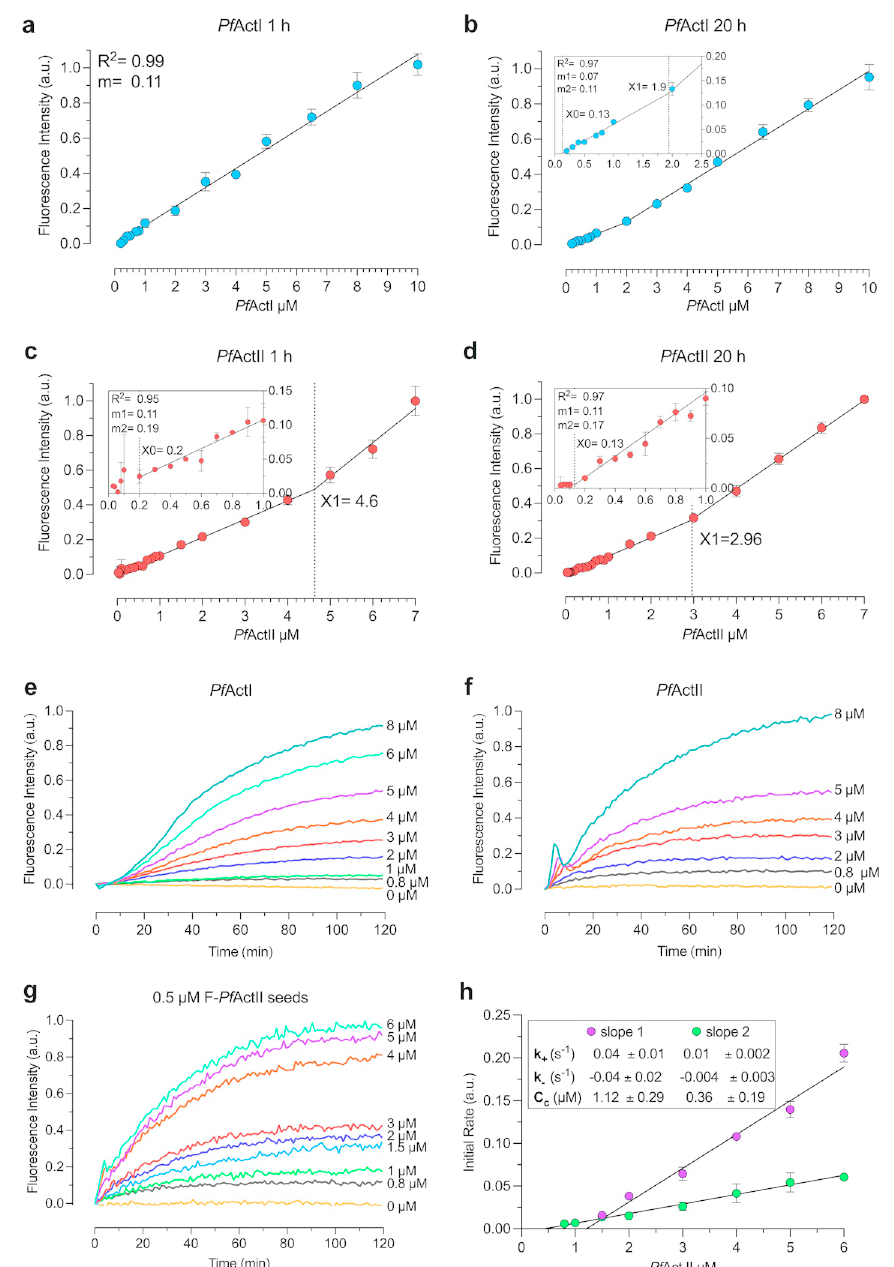
Fig 8. Polymerization kinetics of Plasmodium actins. a-d. C c plots of Plasmodium actins in F-buffer. C c plot of actin I after 1 h (n b = 2) (a) and 20 h (n b = 2) (b) of incubation at 4˚C, using 0.002 to 10 μ M actin. The data fit a single regression line in (a) and a segmented equation in (b) . X0 agrees with the C c previously reported (0.13 μ M), and X1 was 1.9 μ M. C c plot of actin II after 1 h (n b = 5) (c) and 20 h (n b = 3) (d) of incubation, using 0.002 to 7 μ M actin. Actin II exhibited a critical concentration of 0.2 μ M (indicated as X0). The C c decreased to 0.13 μ M after 20 h, as seen in (d). X1 indicates the crossing point value between the two slopes. The lower concentration points are zoomed on the left. Actin II polymerization (e-h) . Spontaneous polymerization curves of pyrene-labeled actin I (n t = 3) (e) and actin II (n t = 3) (f) , induced by the addition of 1x F-buffer. (g) Nucleated polymerization curve of actin II (n t = 3). (h) Elongation rate constants of actin II of the initial phase (slope 1) and the second phase (slope 2) (n b = 3). Error bars represent the standard deviation, a.u. = arbitrary units; n t = technical and n b = biological replicates with 3 technical replicates per experiment. Raw data related to panels a-d can be found in S5 Data, panels e and f in S6 Data, and panels g and h in S7 Data.